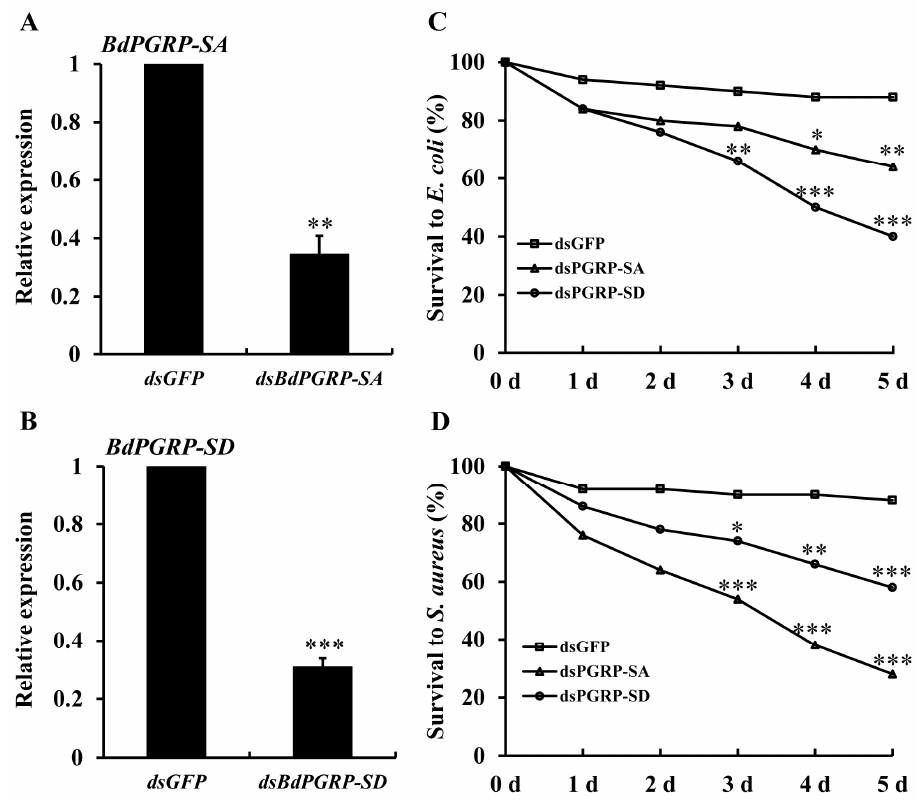
Figure 5. Relative transcriptional expression of BdPGPR-SA and BdPGRP-SD after gene-specific dsRNA injection ( A and B ), and the survival of flies after dsRNA injection followed by E. coli and S. aureus injection ( C and D ). The gene silencing efficiency was detected at 24 h after injection. Survival rates were calculated within 5 days after gene-specific dsRNA injection and E. coli and S. aureus 24 h later. Same amounts of dsGFP was injected as the negative control. Significant differences were determined by the independent samples t -test (* indicates p < 0.05, ** indicates p < 0.01, and *** indicates p < 0.001).